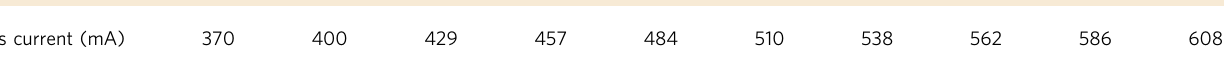
Table 1 Bias currents of the slave QCL leading to synchronization when the bias current of the master QCL is fi xed at 750 mA. The temperature of the master laser is fi xed at 251 K while the temperature of the slave laser is fi xed at 278 K. Bias current (mA)